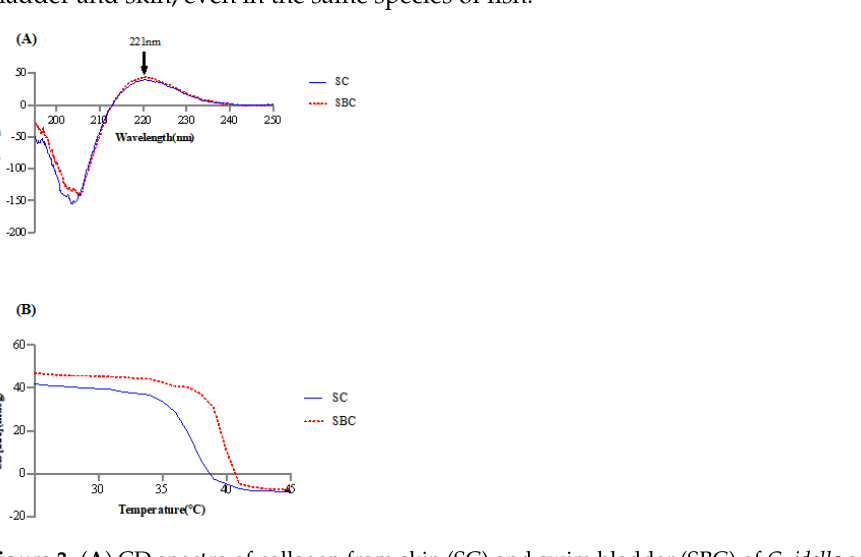
Figure 3. ( A ) CD spectra of collagen from skin (SC) and swim bladder (SBC) of C. idella and ( B ) temperature effect on the CD spectra at 221 nm of collagen from skin (SC) and swim bladder (SBC) of C. idella .